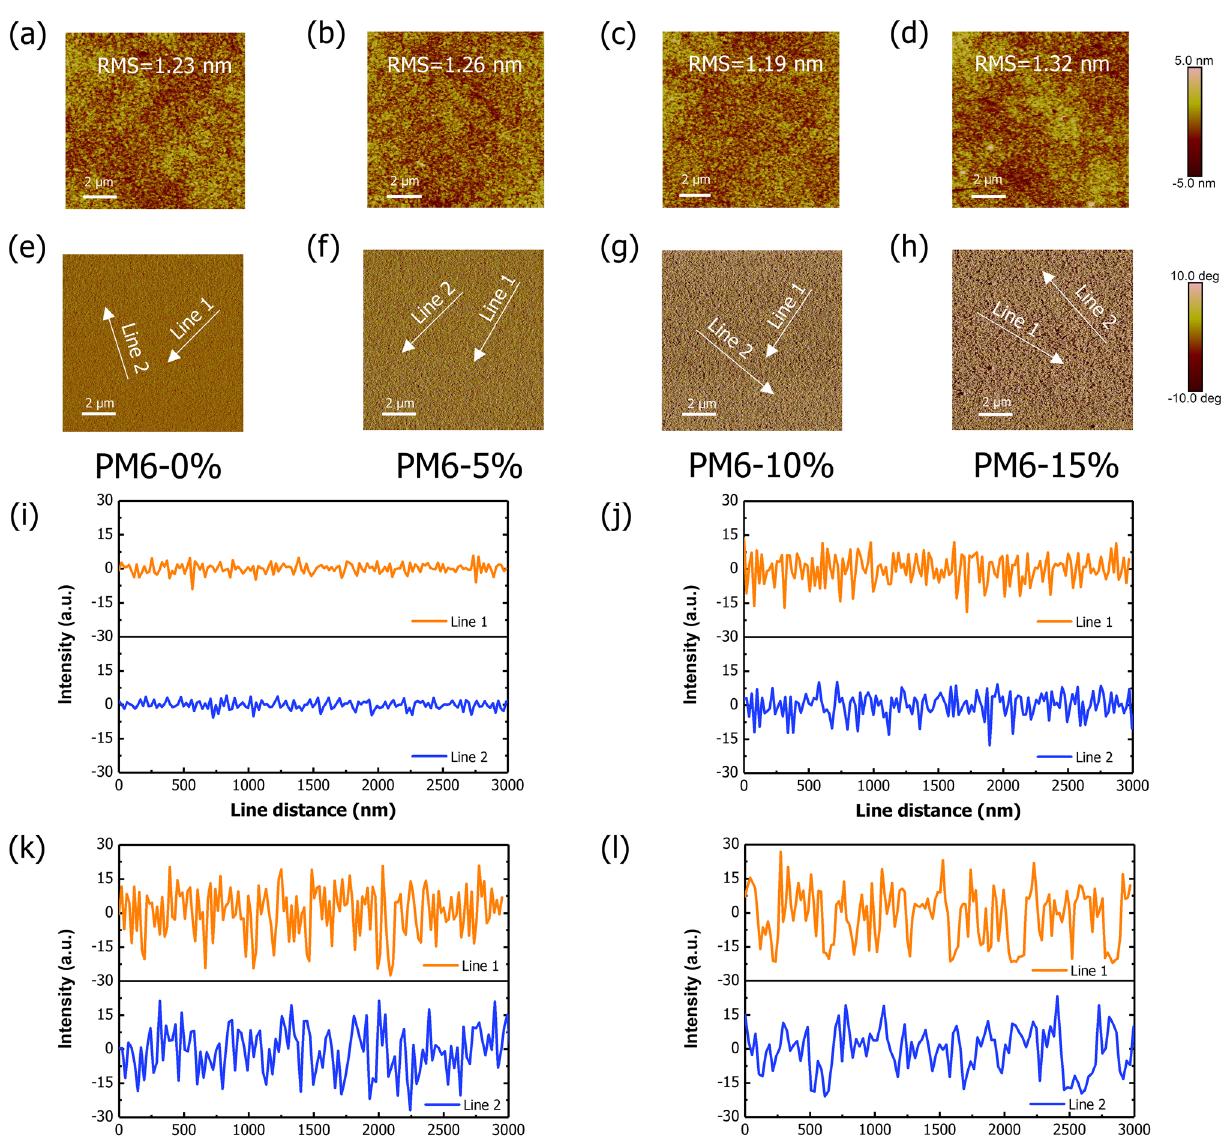
Fig. 5 AFM height images of a pristine PM6 film, b PM6 films with 5% FA-C12, c PM6 film with 10% FA-C12, d PM6 film with 15% FA-C12. AFM phase images of e pristine PM6 film, f PM6 films with 5% FA-C12, g PM6 film with 10% FA-C12, h PM6 film with 15% FA-C12. i Line profiles of AFM signals of PM6 films with different ratios of